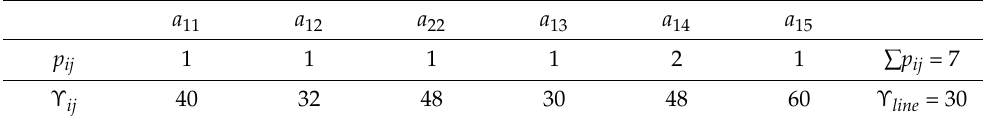
Table 2. Traditional ALB assignment.